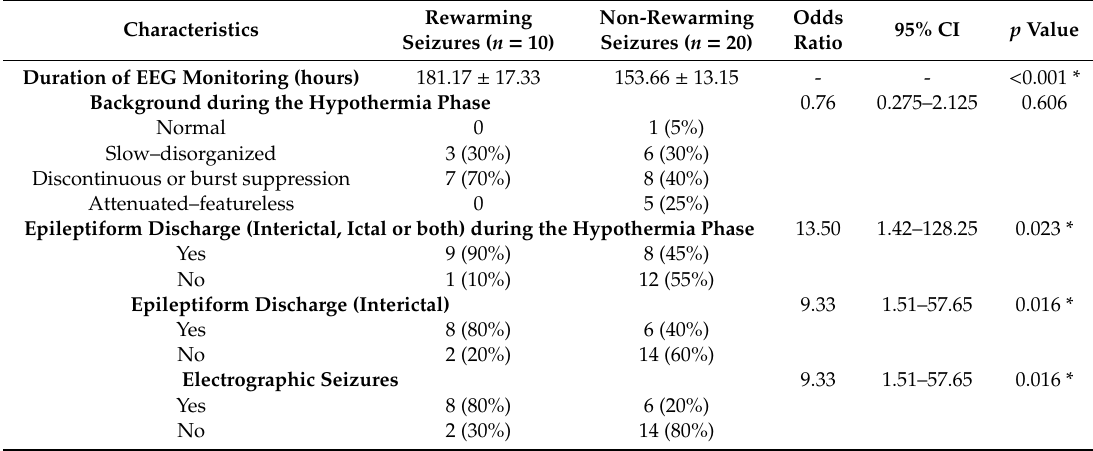
Table 4. EEG finding during hypothermia phase in the 30 children after